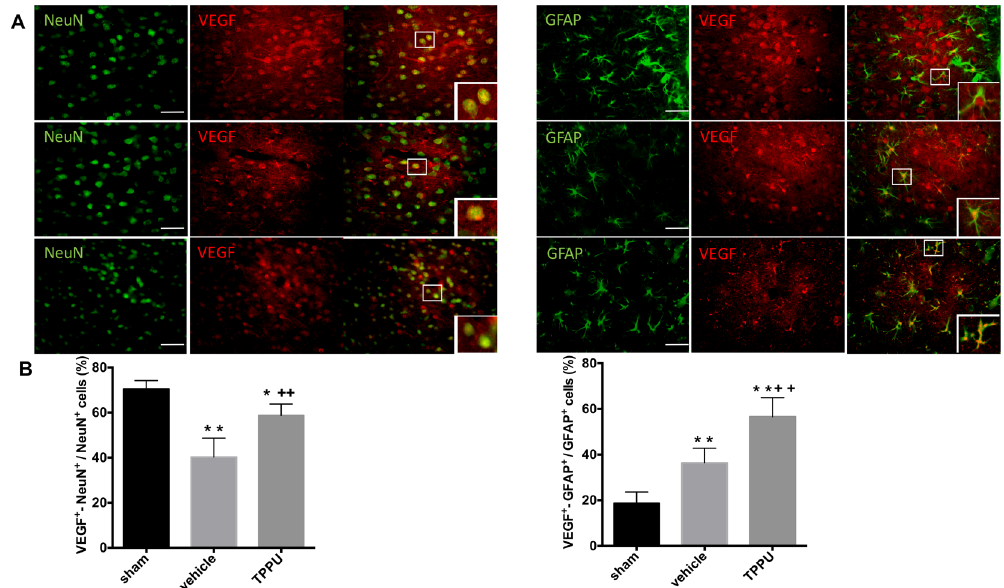
Figure 8. TPPU increases astrocyte-derived VEGF in the cortex at day 2 after MCAO and reperfusion. ( A ) Immunohistochemistry showed two main populations of VEGF-positive cells in ipsilateral cortex: neuron- like NeuN + -VEGF + cells and astroglia-like GFAP + -VEGF + cells. Scale bar = 50 μ m for low power images. Area in white square is shown in inset at higher power. ( B ) Quantification of NeuN + -VEGF + cells in the peri-ischemic cortex showed a decrease in the vehicle group that was attenuated by TPPU treatment. Vehicle- treated rats exhibited an increase in GFAP + -VEGF + cells in the peri-ischemic cortex that was augmented by TPPU treatment. Groups were compared by ANOVA and the Holm-Sidak procedure for multiple comparisons (means ± SD; n = 5 rats per group; * p < 0.05, ** p < 0.01 vs. sham group; ++ p < 0.01 vs. vehicle